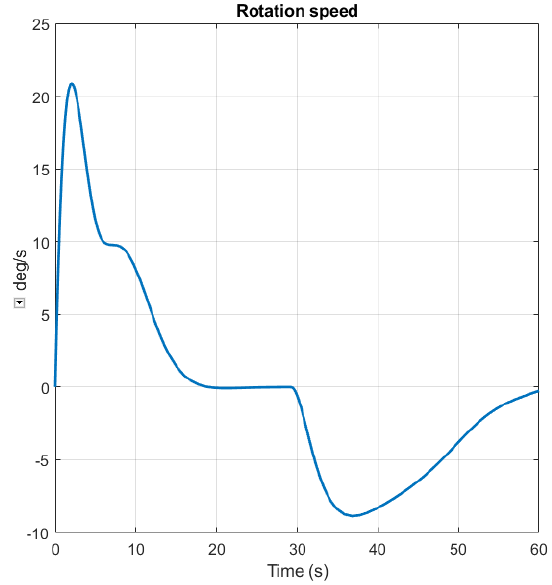
time of the rotation angle of lever AB. Figure 12. Variation versus time of the angular velocity of Figure 11. Varia tion versus Figure 12. Variation versus time of the angular velocity of lever lever AB.